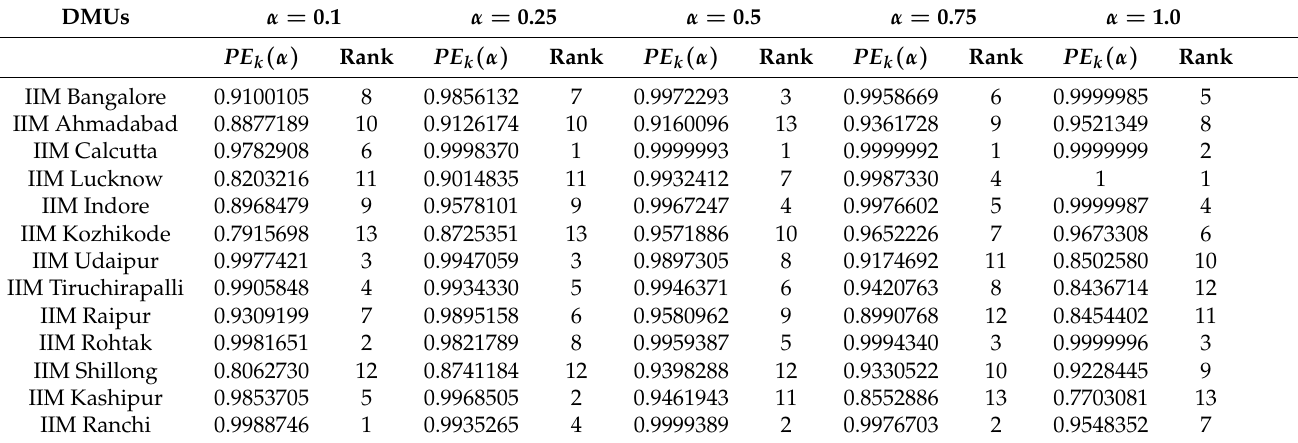
Table 6. Efficiency scores of IIMs and